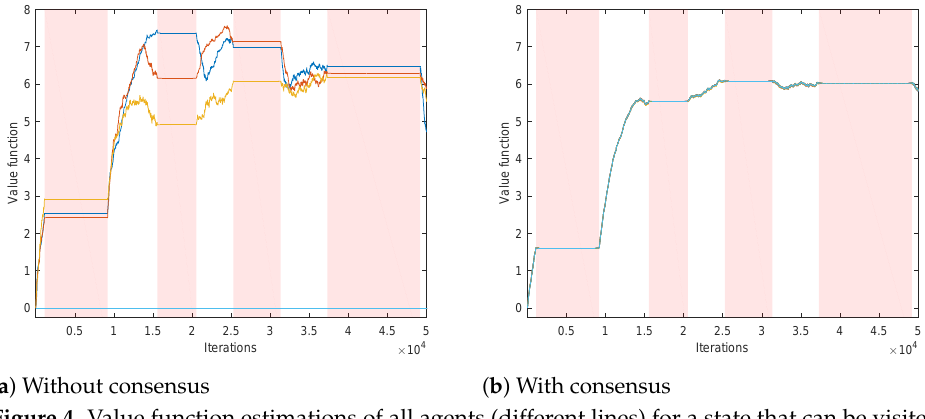
Figure 4. Value function estimations of all agents (different lines) for a state that can be visited by only three agents. Intervals when the corresponding channel is busy are shown in shades of